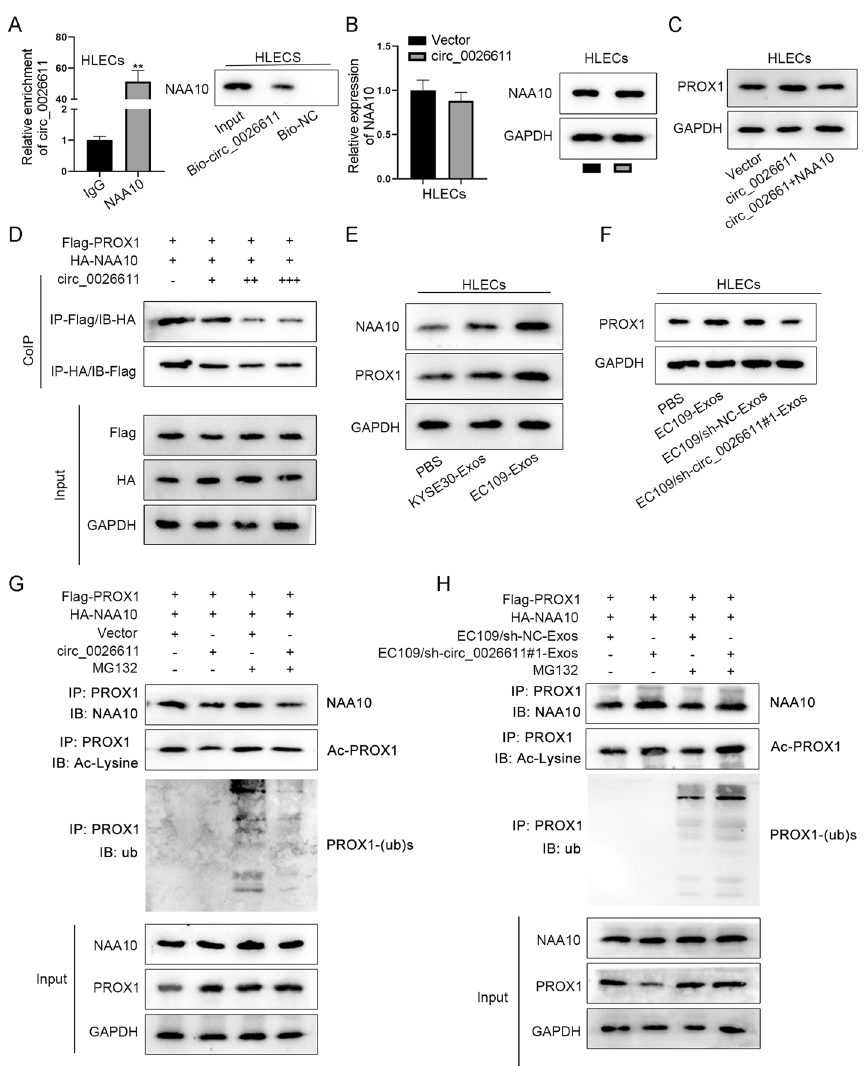
Fig. 6 ESCC exosome circ_0026611 interacted with NAA10 to inhibit the acetylation and ubiquitination of PROX1 in HLECs. A NAA10 enrichment as well as its protein expression in HLECs. B NAA10 expression as well as protein expression affected by circ_0026611. C Protein expression of PROX1 in different conditions. D The effect of circ_0026611 on the interaction between NAA10 and PROX1 was assessed by CoIP. E The expression of NAA10 and PROX1 protein in HLECs under different treatments. F Western blot assay was conducted to test the effect of different EC109-Exos treatments on PROX1 protein. G CoIP assay was used to determine the effect of circ_0026611 on PROX1 protein acetylation and ubiquitination. H CoIP was carried out to assess the effect of EC109-Exos coated with different circ_0026611 expression levels on PROX1 protein. ** P <